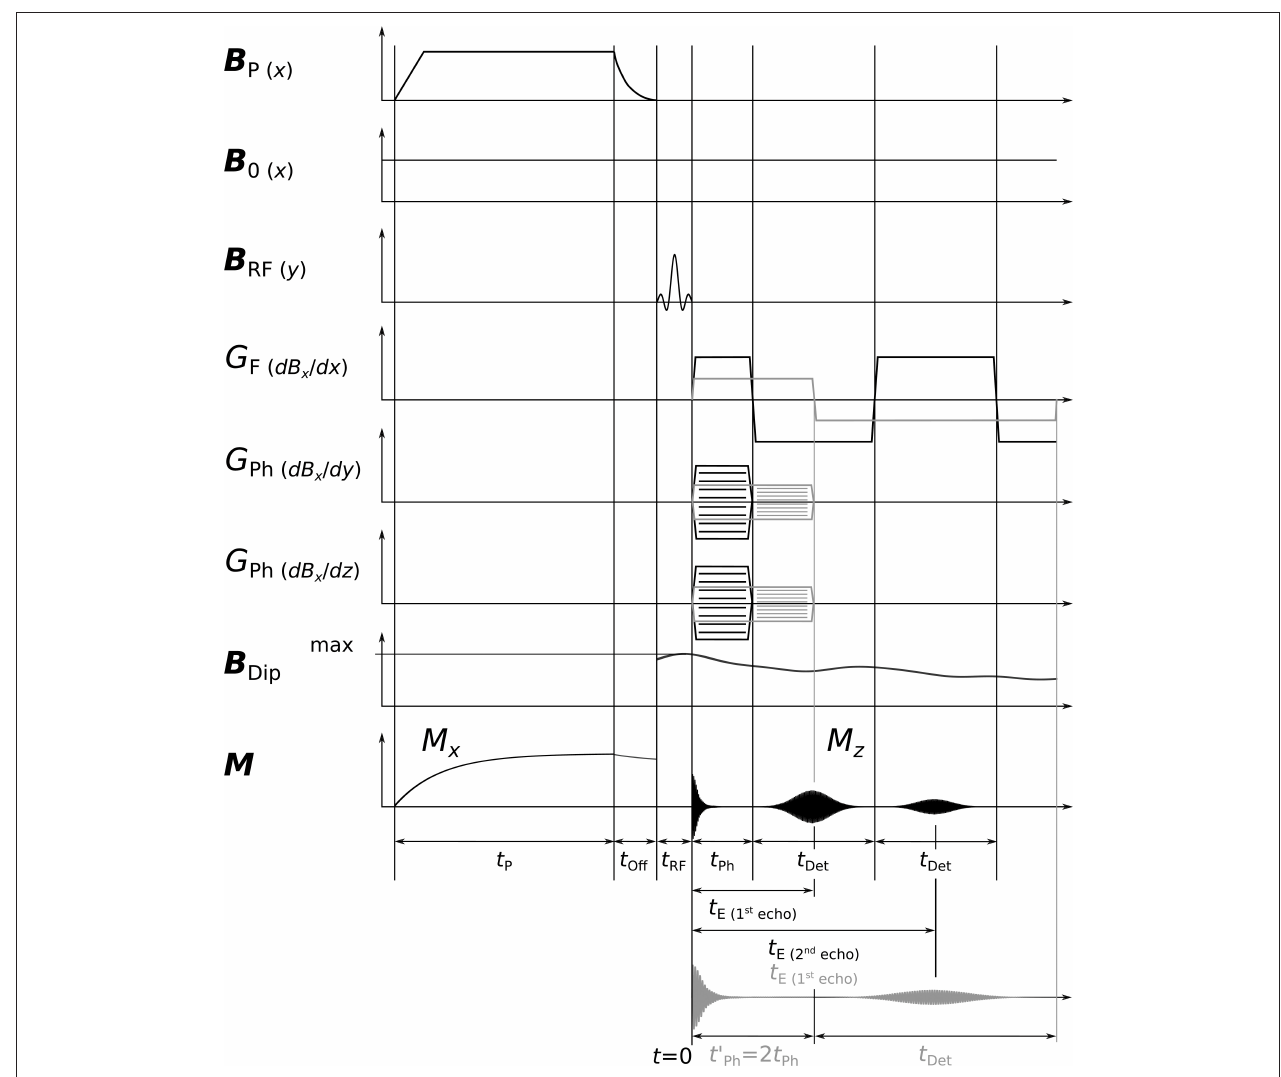
FIGURE 3 | Schematic 3D ULF-MRI sequence. After adiabatic turn-off of B P and a subsequent π /2-pulse, phase encoding gradients G Ph and a frequency encoding gradient G F are utilized and echoes are generated by reversing G F . The dipole field B Dip is applied permanently during the entire encoding period. Exemplary echoes are shown for phase times t Ph and t ′ Ph = 2 t Ph (gray color). In the latter, the gradient strengths are halved giving the same k -space coverage. Time periods t are differently